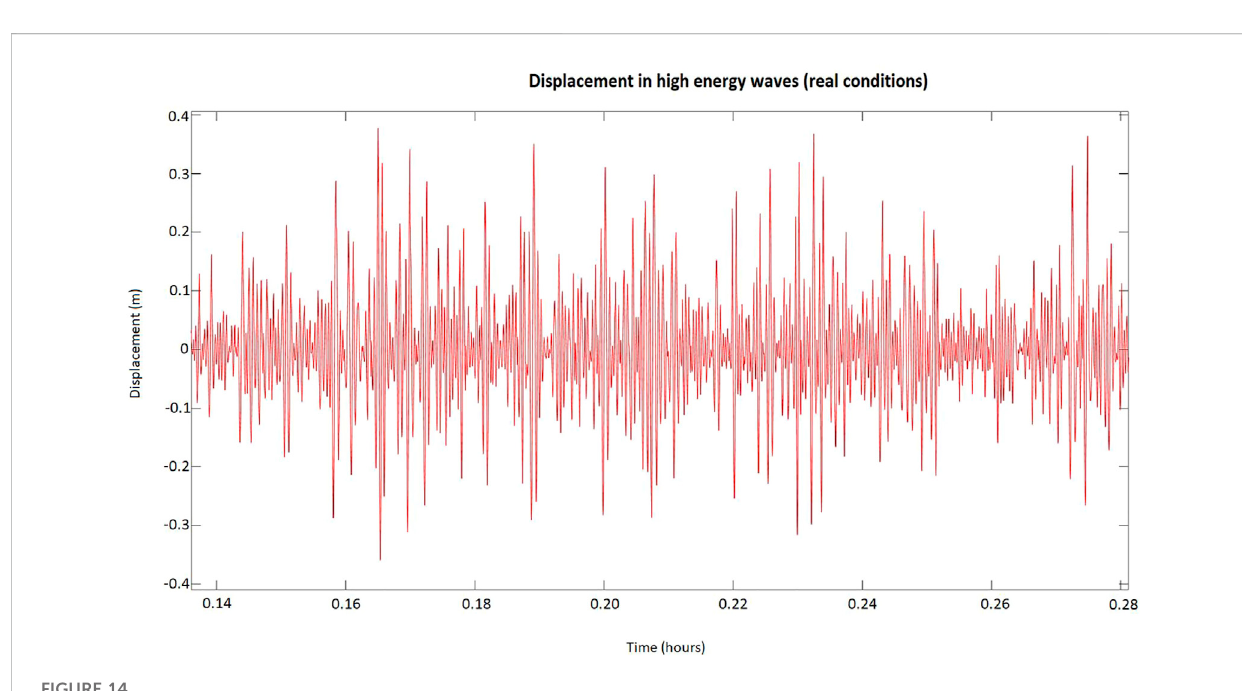
FIGURE 14 High energy